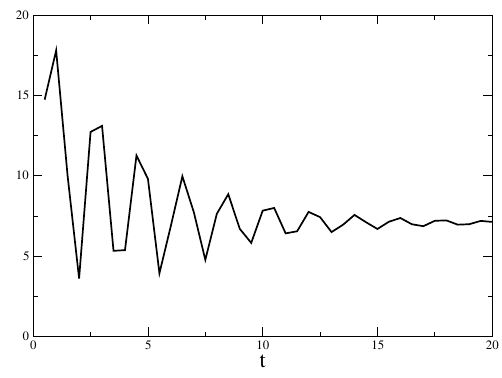
Figure 3. Dynamics of the solution U n